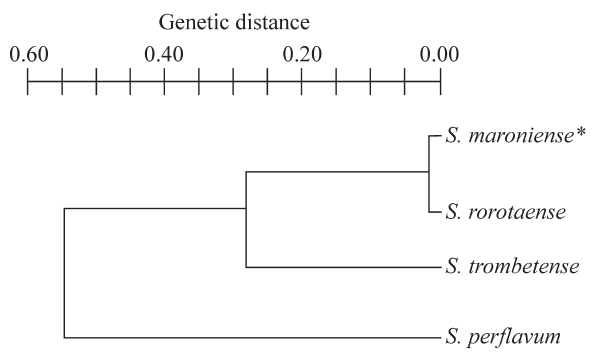
Figure 1 - Dendrogram of the Nei genetic distance among four species of the Simuliumperflavum group,basedontheUPGMAmethod.Cophenetic correlation = 0.996. * Simulium maroniense cytotype D.